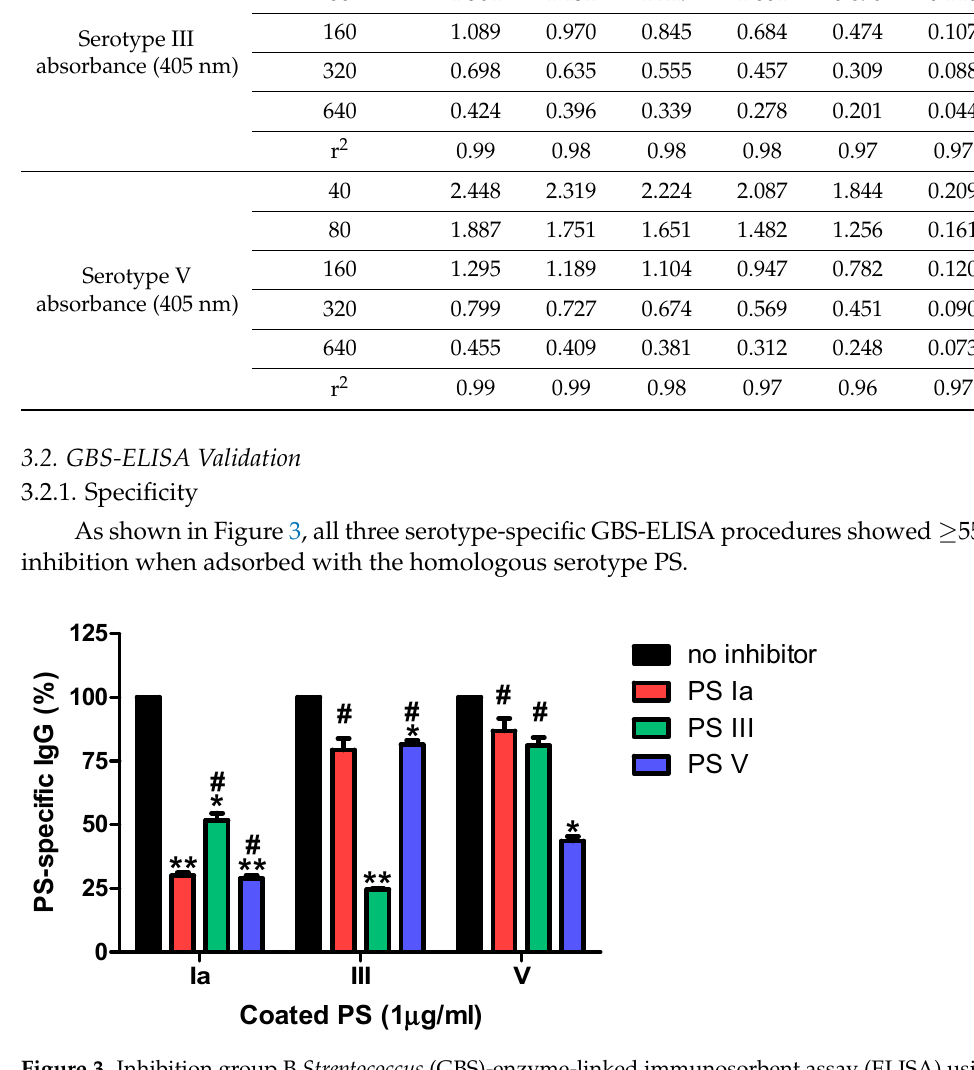
Figure 3. Inhibition group B Streptococcus (GBS)-enzyme-linked immunosorbent assay (ELISA) using homologous or heterologous GBS polysaccharide (PS). To confirm specificity of PS-ELISA, pooled serum samples were adsorbed with PS Ia, III or V (10 µ g/mL) for 1 h. Black bars (no inhibitor) indicate percentage determined by measuring PS-specific IgG without inhibitor. This assay was conducted in duplicate. Error bars are standard deviations of each condition. * p < 0.05, ** p < 0.01 compared to the results without inhibition by PS (no inhibitor). # p < 0.05 compared to the results with inhibition by homologous